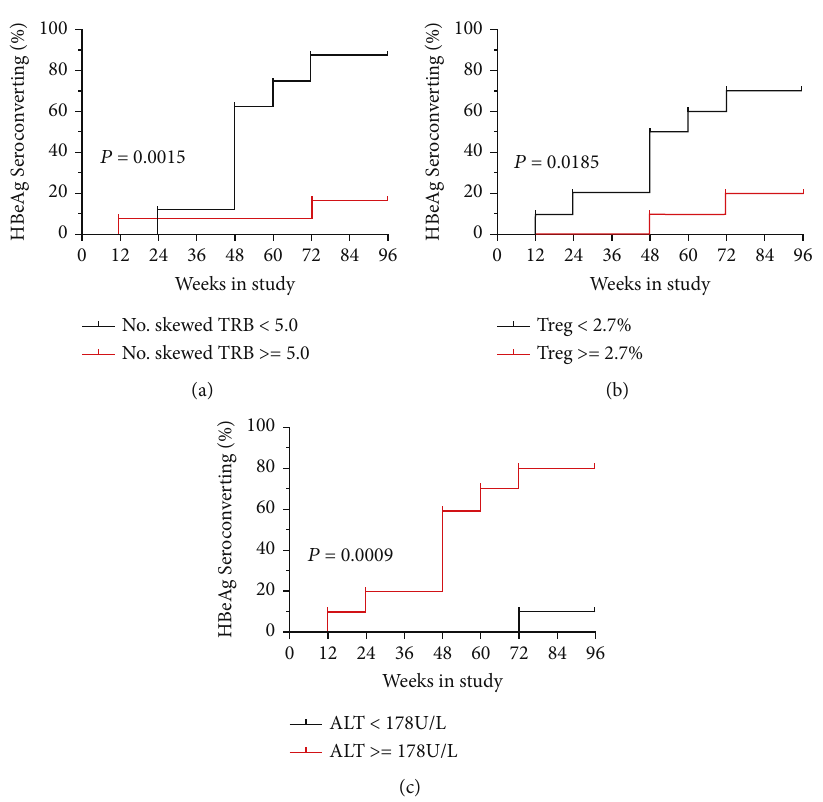
Figure 5: Prognostic value of the number of skewed TRBV families, Treg frequencies, and ALT levels in CHB subjects with or without HBeAg seroconverting (SC). The prognostic cuto ff value of the number of skewed TRBV families at 48 weeks (a), Treg frequencies at 72 weeks (b), and ALT levels at baseline (c) in predicting the HBeAg SC of CHB subjects during TDF treatment for 96 weeks. The log-rank test was used to compare the di ff erence of HBeAg SC among the CHB subjects during TDF